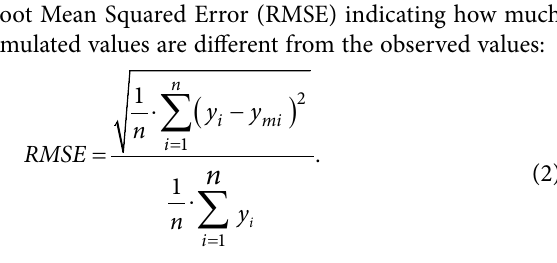
Figure 2. The cartogram of the current transport flows in Kaunas